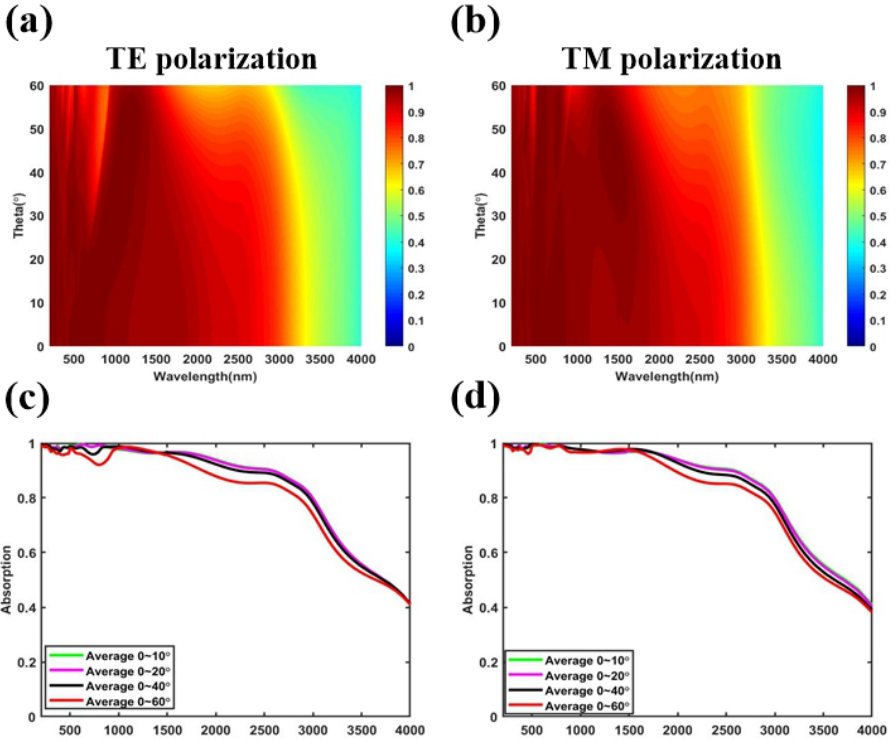
Figure 7. Absorption map of the proposed solar energy absorber with different incident angles under ( a ) TE polarization and ( b ) TM polarization, the average absorption for oblique incidence of ( c ) TE polarization and ( d ) TM